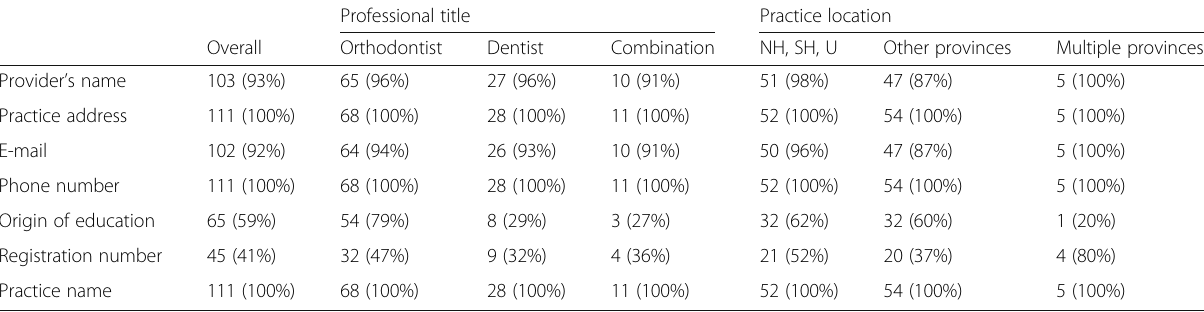
Table 1 Reporting of mandatory information items by the examined websites according to CED guidelines (in parentheses, the respective percentages)